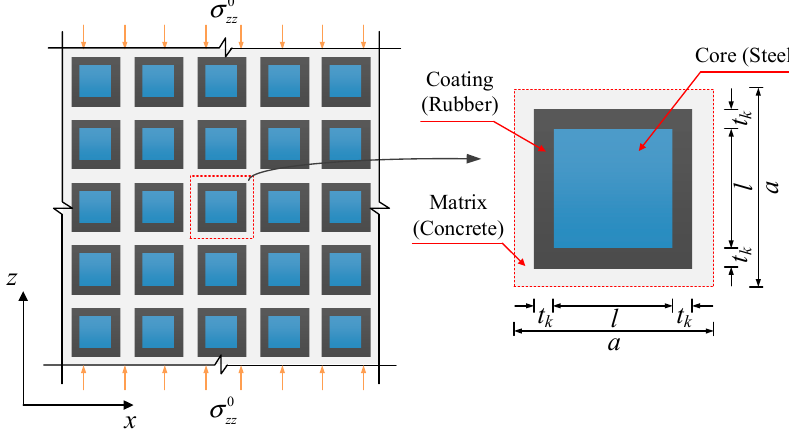
Figure 1. Cross section of a 2D periodic foundation and its typical unit cell.